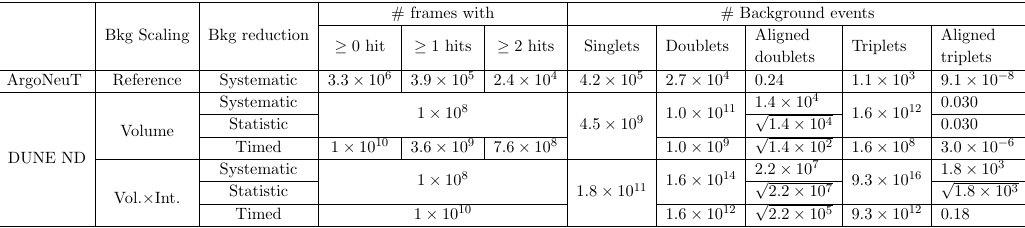
Table 2 . Background considerations. The DUNE ND background is scaled from ArgoNeuT back- ground with two options, Scaling A (scaled with the number of frames and detector volume) and Scaling B (scaled with POT, detector volume and inverse square of distance) as speci(cid:12)ed in the text. The number of background singlet, doublet and triplet events with and without alignment with the beampipe requirement are listed in the later part of this table. Three DUNE ND back- ground reduction options are considered, including no reduction, reduced to statistical uncertainty only, and further reduced by using timing information, labeled by \Systematic", \Statistic" and \Timed", respectively.